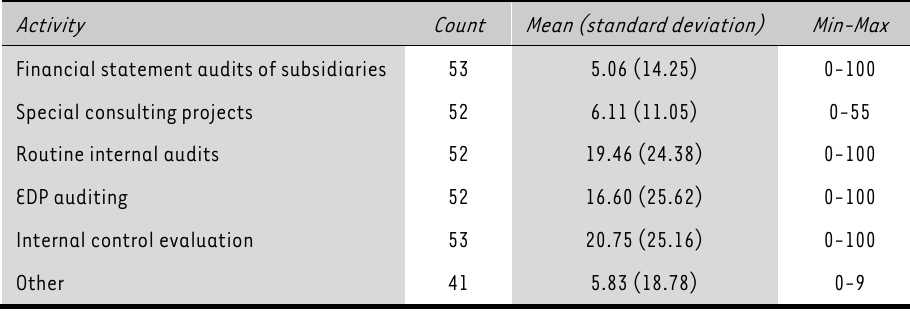
Percentage breakdown of outsourced internal audit hours by